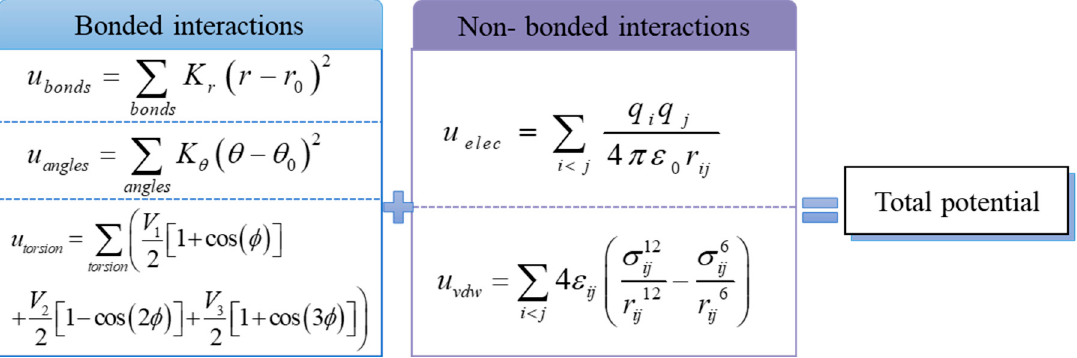
Figure 2. Composition of the force field.